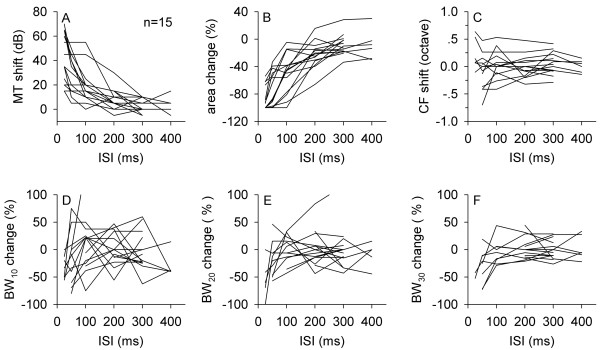
Population data showing the time-dependent modulation of frequency tuning by preceding noise (masker). Each line in the drawings depicts the data from one neuron including (A) the effect of masker on MT, (B) the percentage of area change of FLRF, (C) the CF shift, (D) the percent BW10 change, (E) the percent BW20 change, and (F) the percent BW30 change.